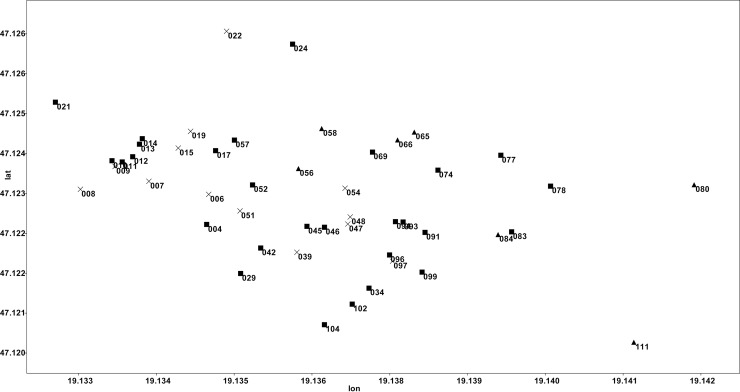
Location of the ponds in latitude-longitude coordinate system.The marks indicate the macrophyte belt categories: cross = “transparent” group, filled square = “transitional” group, filled triangular = “turbid” group.